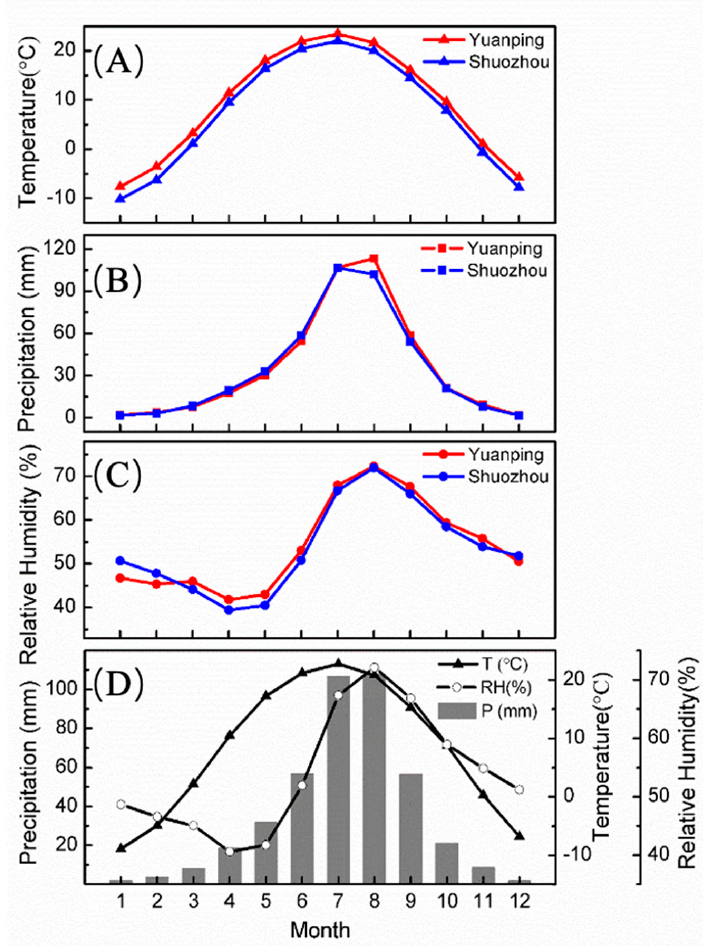
Figure 2. Monthly distribution of ( A ) temperature, ( B ) precipitation, ( C ) relative humidity and ( D ) arithmetical average of climatic factors from Yuanping and Shuozhou meteorological stations (1957 ‒ 2013 AD).